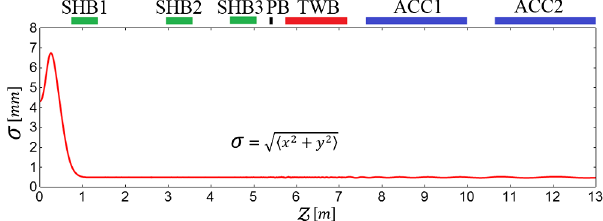
FIG. 13. Variations of the rms beam radius from the beam waist to the end of the injector using the envelope equation.